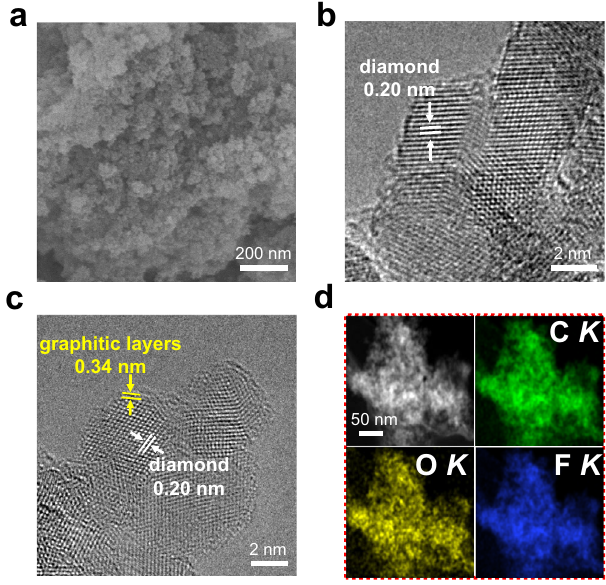
Fig. 1 Microscopic characterization of ND and F-ND catalysts. a SEM image of F-ND catalysts. b TEM image of ND catalysts. c High-resolution TEM image, and d corresponding elemental maps of F-ND catalysts, showing the distributions of C K (green), O K (yellow), and F K